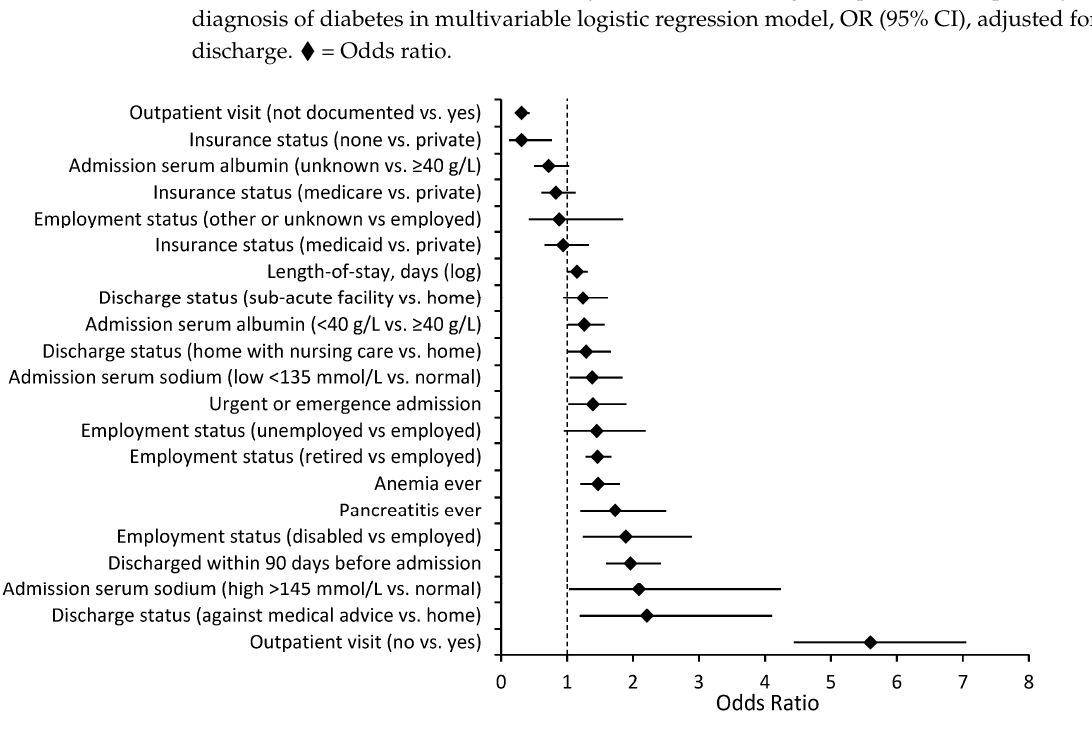
Figure 2. Risk factors for all-cause 30-day readmission among 4027 patients with secondary discharge diagnosis of diabetes in the multivariable logistic regression model, OR (95%CI). Adjusted for year of discharge. = Odds ratio.